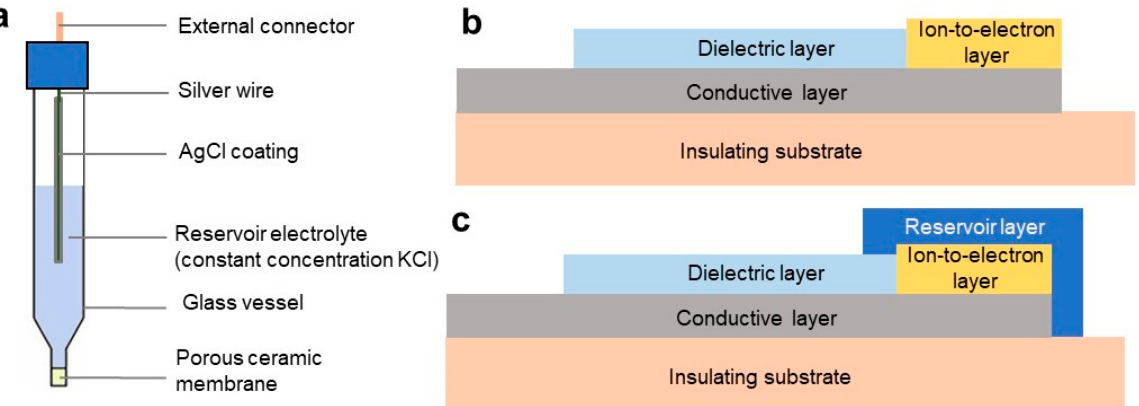
Figure 3. ( a ) Illustration of the components present in a traditional reference electrode. ( b , c ) Stratified view presenting structural differences between a printed pseudo-reference electrode ( b ) and a printed reference electrode ( c ).